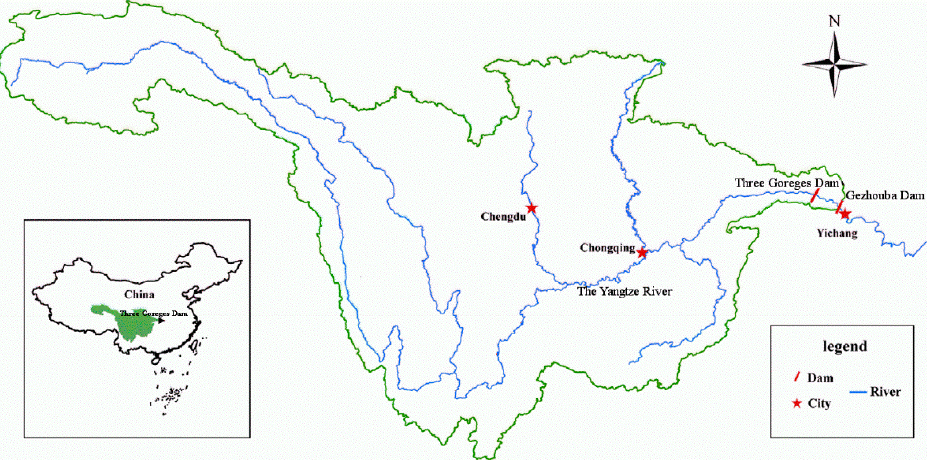
Figure 3. The location of the Three Gorges Reservoir–Gezhouba (TGR–GZB) cascade reservoirs in China.